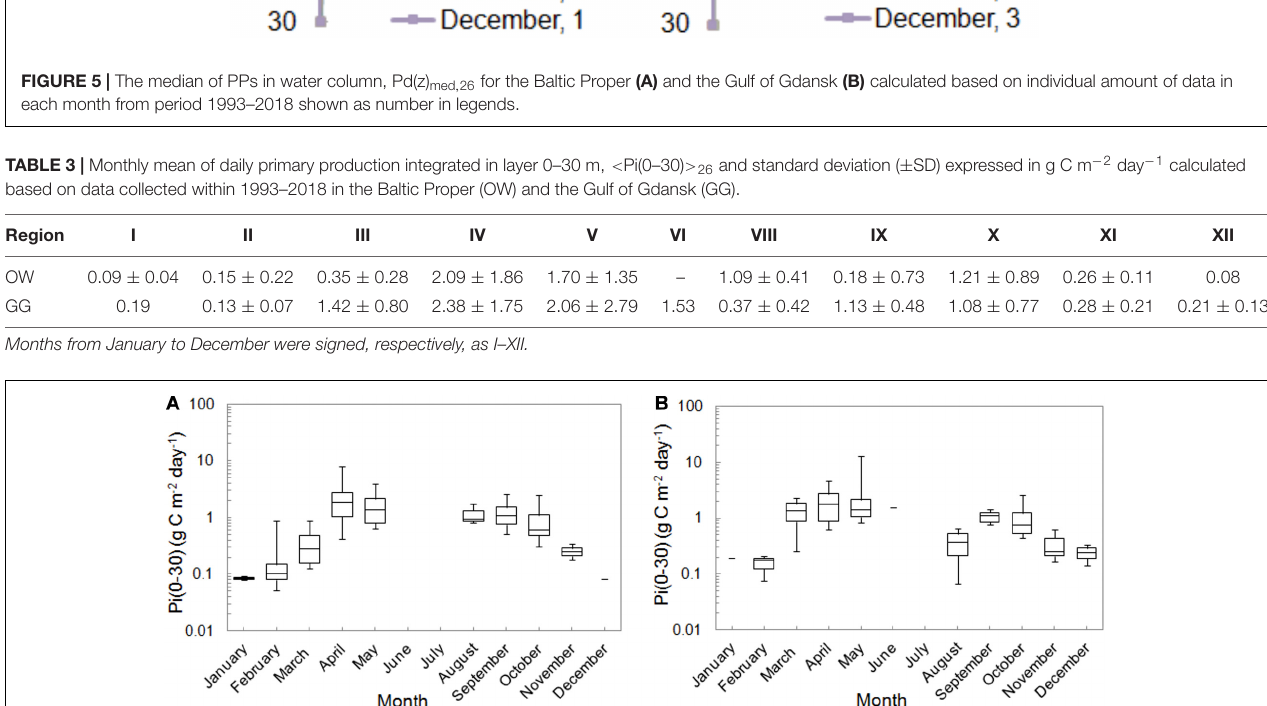
FIGURE 6 | The monthly distributions of integrated PPs, Pi(0–30) in the Baltic Proper (A) and the Gulf of Gdansk (B) within 1993–2018. The line indicates median values, 25th and 75th percentile of data as well as their minimal and maximal values.